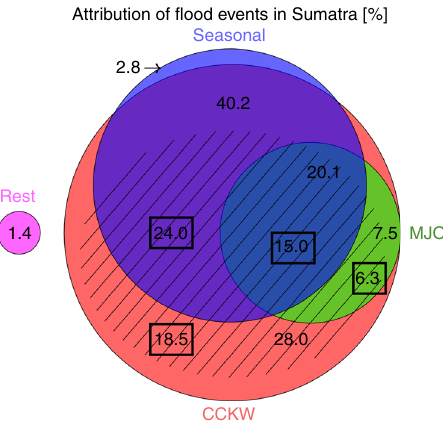
Fig. 6 Attribution of fl ood events in Sumatra. Data presented as scaled Venn diagram. Total area of the blue circle represents 63.1% of fl oods associated with above-average seasonal precipitation. Total area of the green circle represents 27.6% fl oods associated with favorable Madden Julian Oscillation (MJO) conditions MJO in phases 2 – 5). Total area of the red circle represents 95.8% fl oods associated with convectively coupled Kelvin wave (CCKW) activity (precipitation anomaly above 2.5 mm/day), while hatching indicates strong CCKWs (precipitation anomaly above 5 mm/day). Numbers indicate percentage of fl oods in respective categories. Numbers in boxes represent strong CCKWs. The magenta circle represents 1.4% of all fl oods, which were not attributed to either category considered. The diagram is based on Twitter